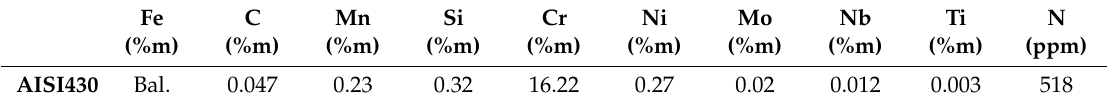
Table 2. Chemical composition of AISI 430 steel used as substrate. Source: APERAM, 2016. Fe C (%m) (%m)